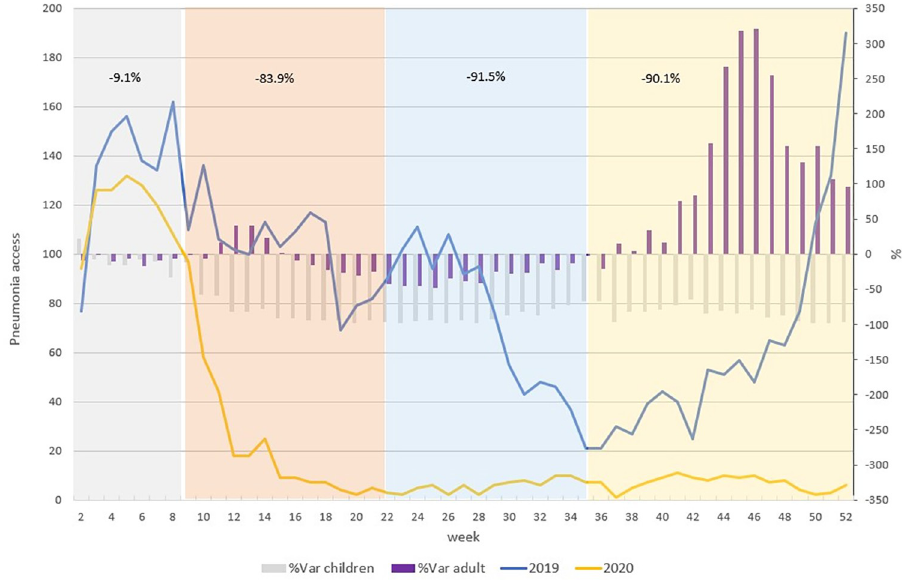
Fig 2. Weekly trend of pediatric access to ED for suspected COVID-19 pneumonia (2019, 2020). The blue line refers to pediatric ED accesses in 2019 for pneumonia, the yellow line refers to pediatric ED accesses in 2020 for pneumonia. The grey bars indicate the percent variation of pediatric ED accesses for pneumonia in 2020 and 2019 and purple bars indicate the percent variation of ED accesses for pneumonia in 2020 and 2019 for the adult population. Different colours of the time represent the four phases of the pandemic in 2020: Grey = pre-lockdown, orange = lockdown, light blue = post lockdown and yellow = the second wave.The trend of pneumonia ED visits in 2020 shows an important decreas starting from the first week of February to mid-April and then became stable with a number of accesses lower than 20 by week. This trend in the adult population is different. For adults there was an increment during the lockdown period, a decrease during the second part of the lockdown period and the summer and then a clear increase during the 2 nd wave reaching a growth of access of 321% in November 2020 compared to the same week in 2019 (1,794 vs